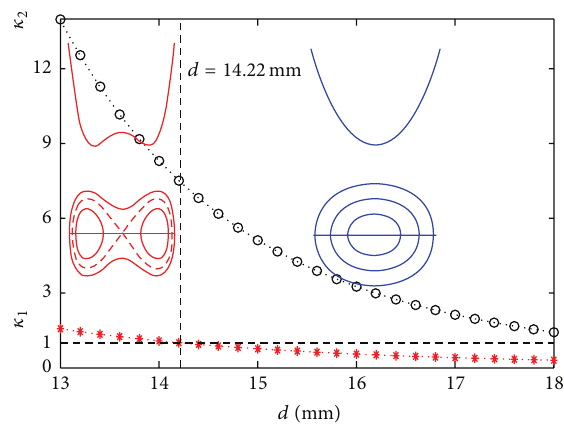
Figure 3: Change of 𝜅 1 and 𝜅 2 with respect to 𝑑 , and the topological shapeofthepotentialenergycurvesandphaseportraitscorrespond- ing to both sides of the bifurcation